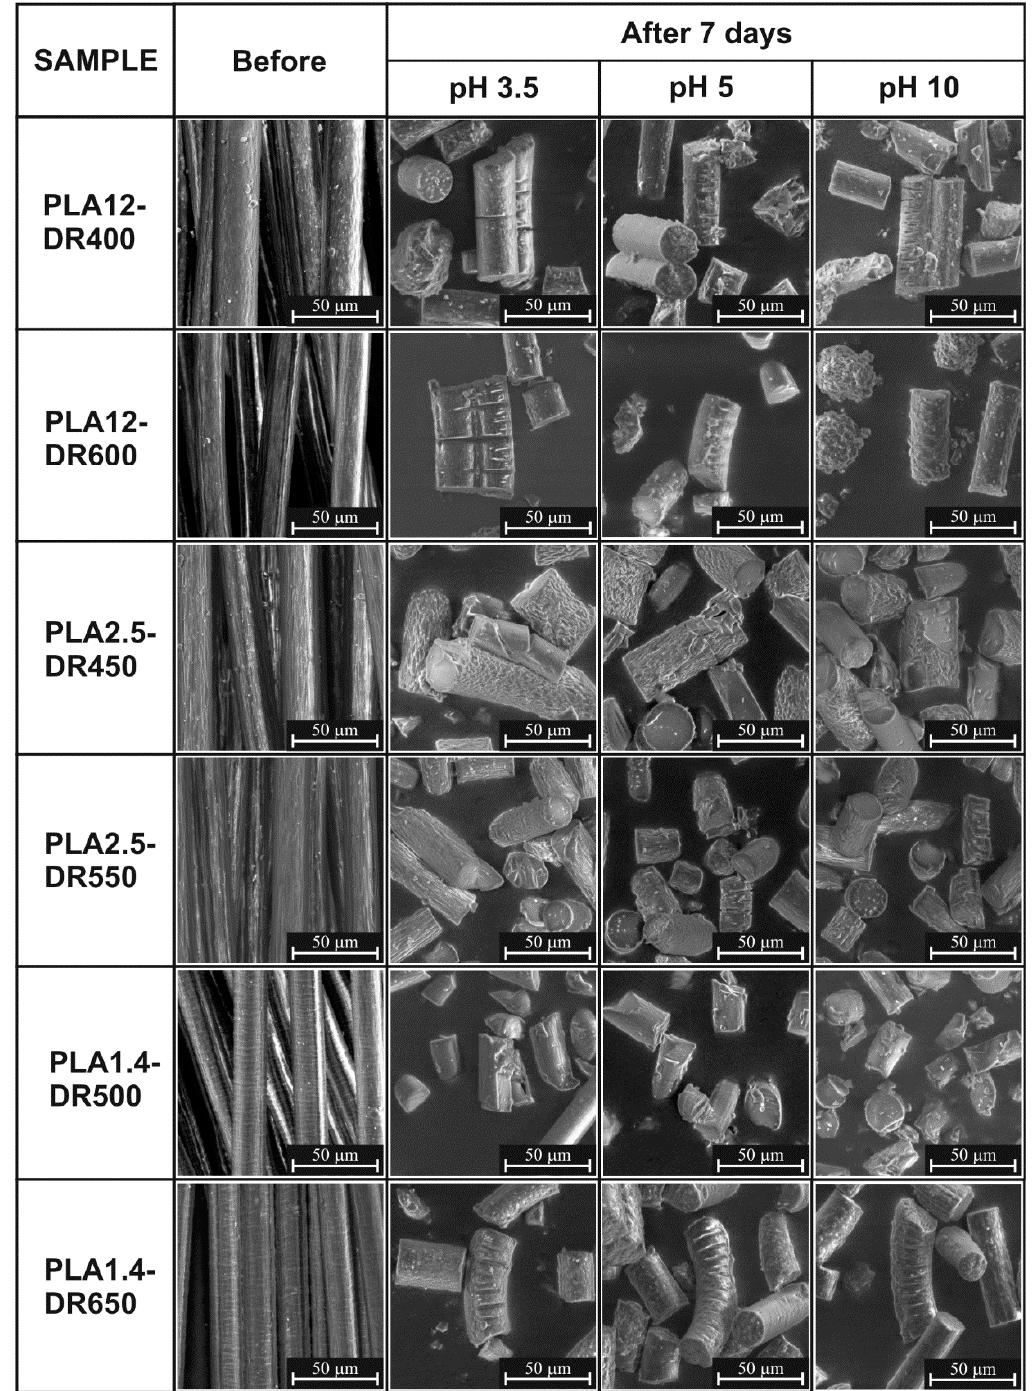
Figure 2. SEM results of the studied samples recorded before and after seven days of thermal- supported hydrolytic